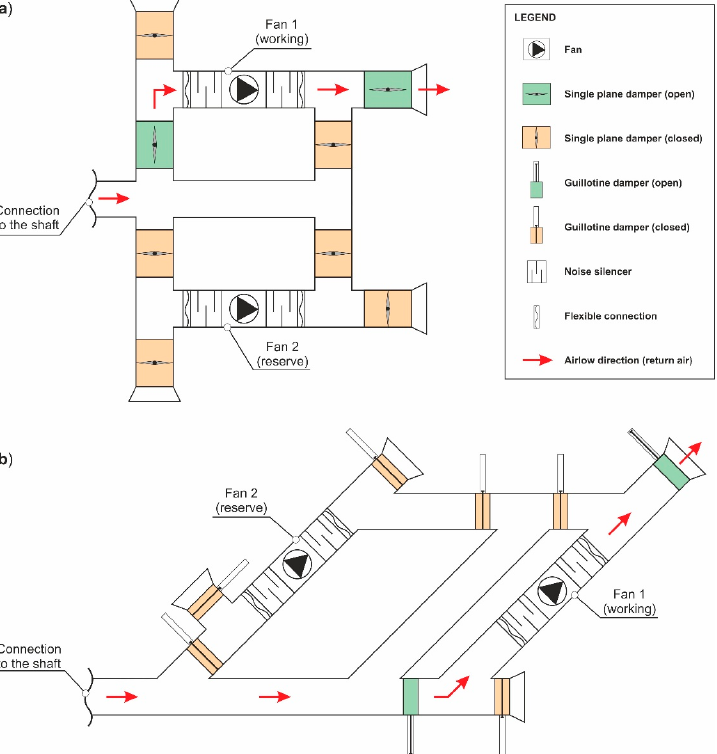
Figure 7. Example of fan station ducting layout: ( a ) solution no. 1; ( b ) solution no. 2.